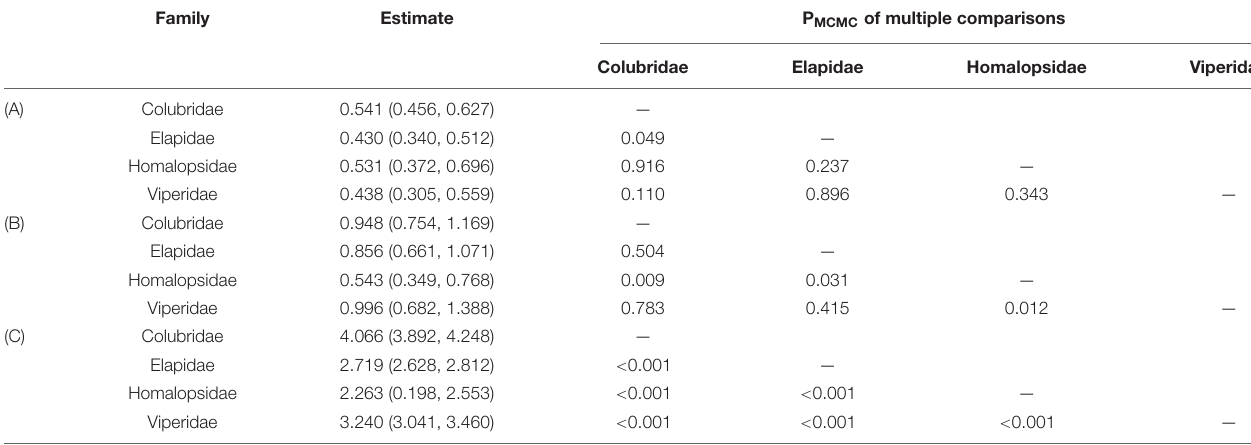
TABLE 2 | Summary of posterior distributions and multiple comparisons of scaling coefficients (A), proportionality coefficients (B) and relative eye diameters (C) among four clades. Family Estimate P MCMC of multiple comparisons